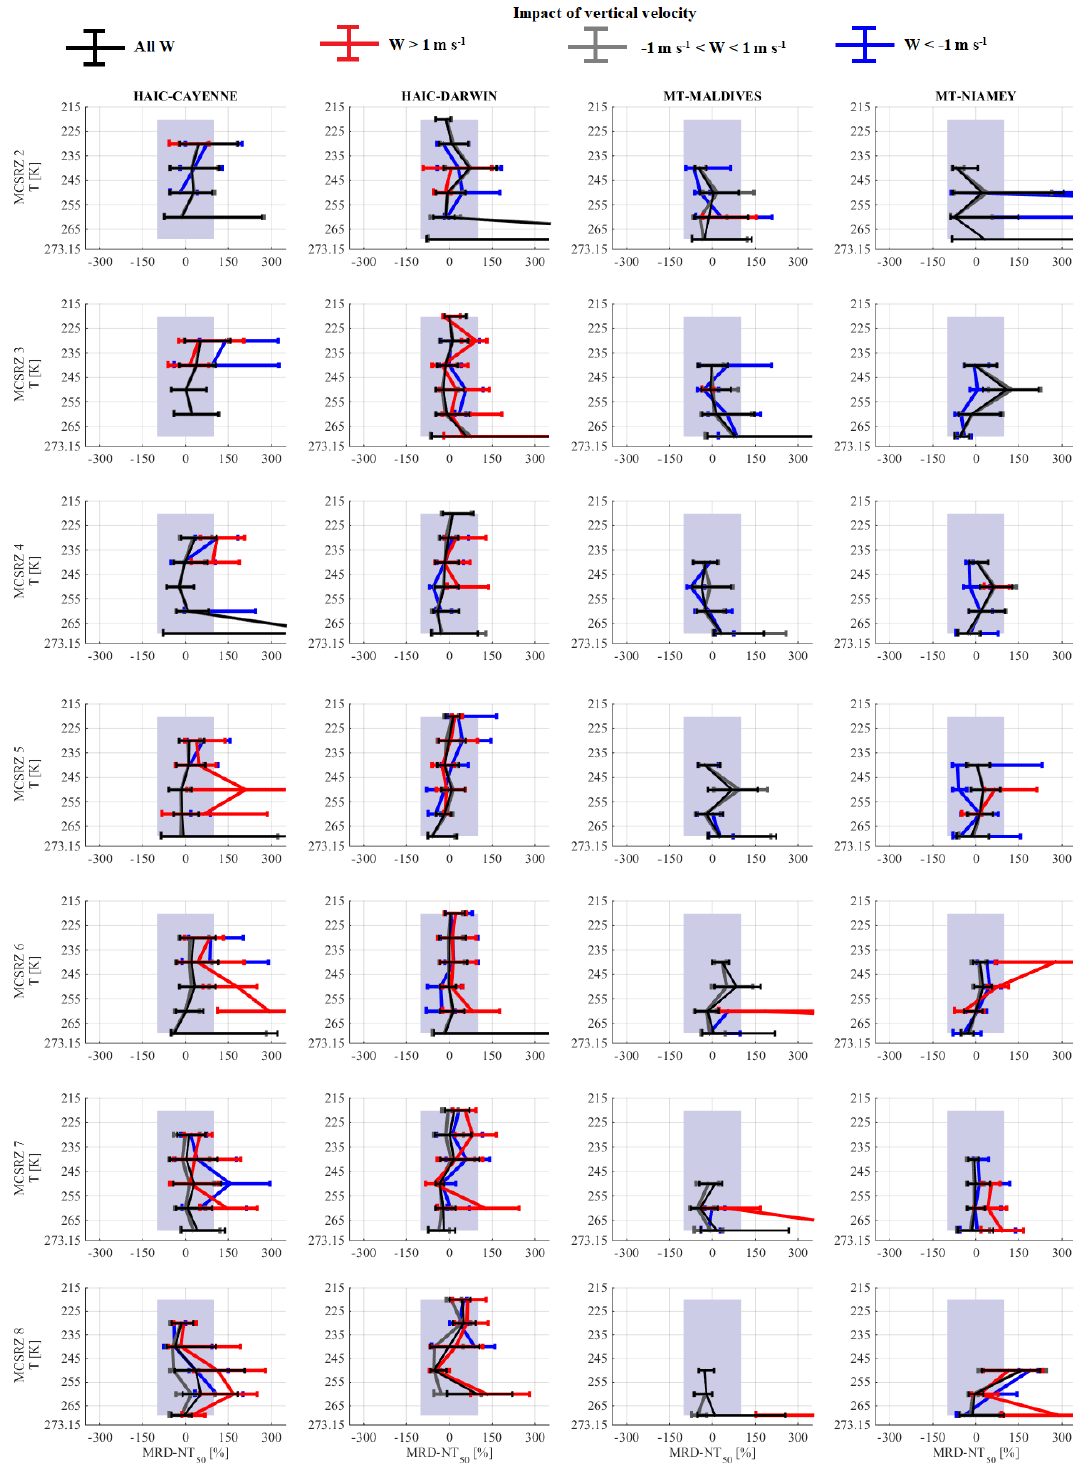
Figure B3. Median relative difference of concentration of hydrometeors summed over D max for D max larger than 50µm (MRD-NT 50 ) in regard to median total concentrations calculated for the merged dataset in each MCS reflectivity zone (Fig. 9). Results are sorted as a function of MCSRZ 2 (top line) to MCSRZ 8 (bottom line). The blue lines represent MRD-NT 50 for vertical velocity smaller than − 1ms − 1 . The grey lines represent MRD-NT 50 for vertical velocity larger than − 1ms − 1 and smaller than 1ms − 1 . The red lines represent MRD-NT 50 for vertical velocity larger 1ms − 1 . The black lines represent MRD-NT 50 when there is no distinction as a function of vertical velocity (as in Fig.